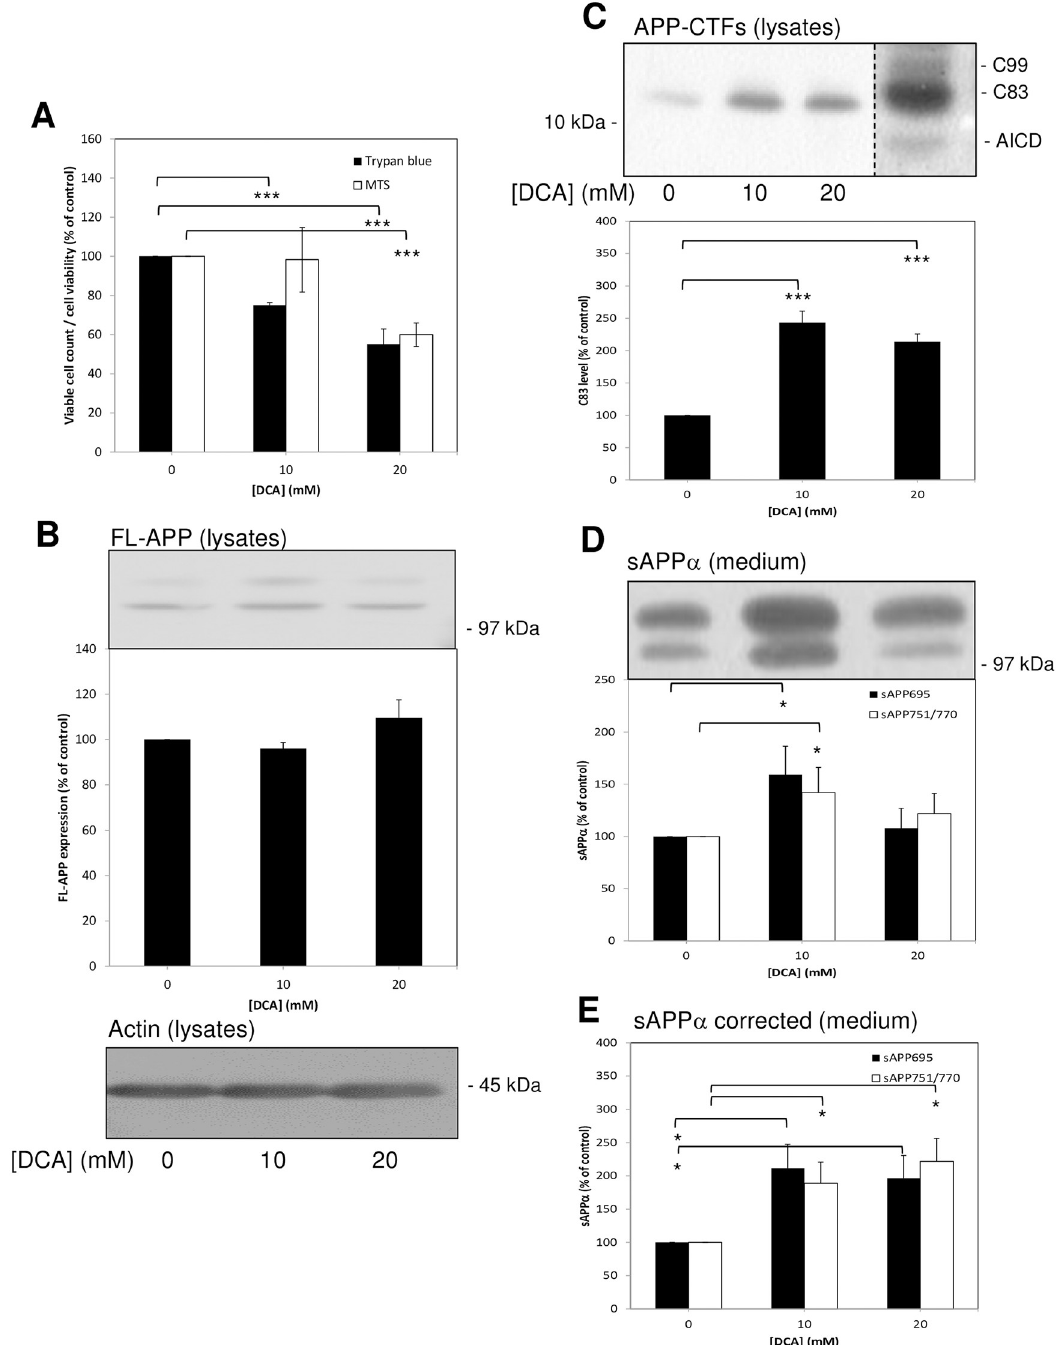
Fig 1. Growth of untransfected SH-SY5Y cells in the presence of DCA enhances non-amyloidogenic APP processing. Cells were seeded and cultured in the absence or presence of the indicated DCA concentrations and grown until the control cultures reached confluence (medium and DCA were replaced every two days). At this point the growth medium was replaced with UltraMEM containing the same DCA concentrations and the cells were cultured for an additional 24 h. Viability assays were then performed or cell lysate and conditioned medium samples were prepared as described in the Materials and methods section. Equal amounts of protein (lysates) or equal volumes (medium) from samples were subjected to SDS-PAGE and immunoblotting (Materials and methods). (A) Trypan blue and MTS cell viability assays. ( B ) Lysates were immunoblotted with anti-APP C-terminal and anti-actin antibodies. Full-length APP (FL-APP) was quantified from multiple immunoblots and the results expressed relative to control values. (C) Lysates were resolved on Tris/tricine gels and immunoblotted with anti-APP C-terminal antibody to detect APP